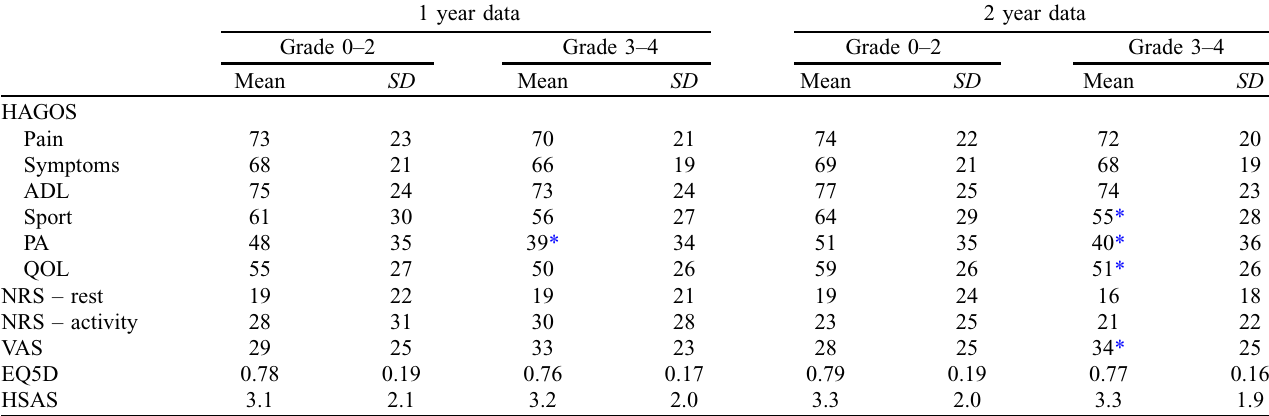
Table 3. Influence of cartilage injury on patient reported outcome in patients undergoing arthroscopic FAI